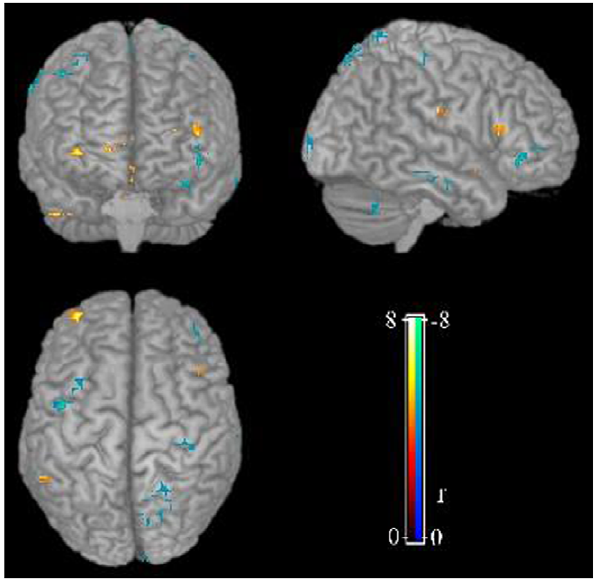
Figure 2. ALFF analysis revealed regional functional alteration in MCI group compared to controls. Compared to the control group, both increased and decreased regional function was revealed in MCI group in relative to controls.